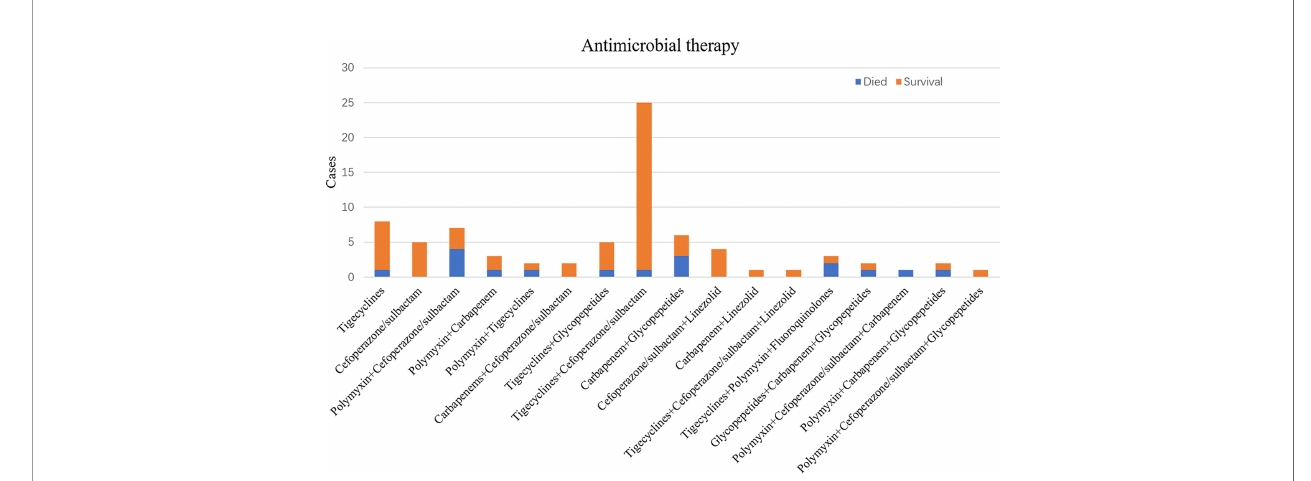
FIGURE 7 | Antimicrobial therapy classi fi cation of 78 patients with co-infection treated with antimicrobial drugs and mortality.